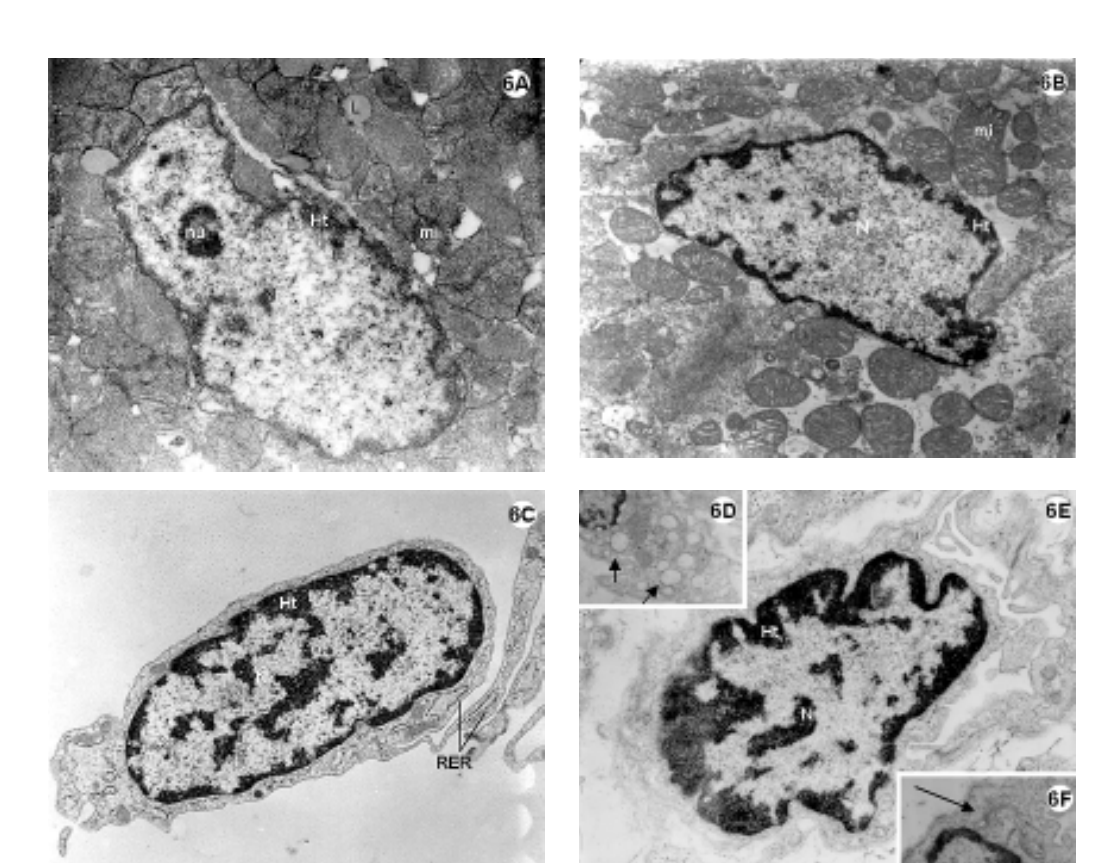
Fig. 6 - Electron photomicrography of the lateral wall of the left ventricle of the rabbit heart submitted to the Langendorff System and perfused with Ringer Locke solution for 2 hours. 6A-F: Control group. 6A-6B: Nuclei of myocardial cells (N) with heterochromatin (ht) associated with nuclear covering and in disperse masses within the nucleus (chromocenters). Nucleoli (nu) evident (6A). Mitochondria (mi) rich in decompacted with granules of associated lipid